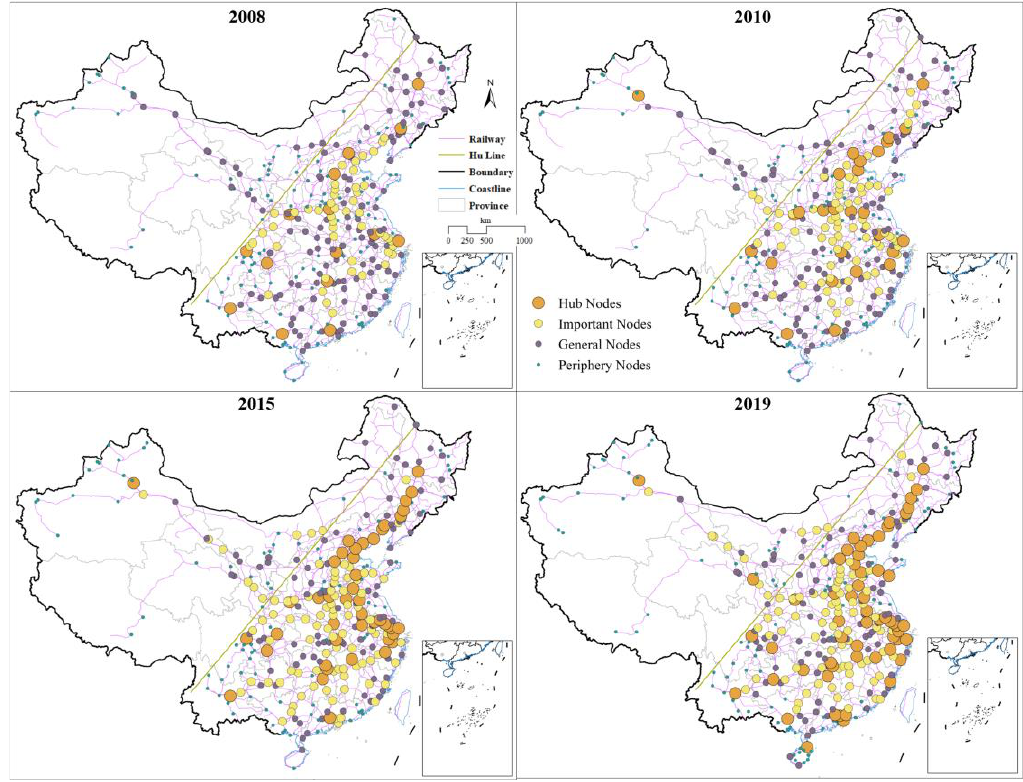
Figure 7. Clustering of the city nodes in different years.